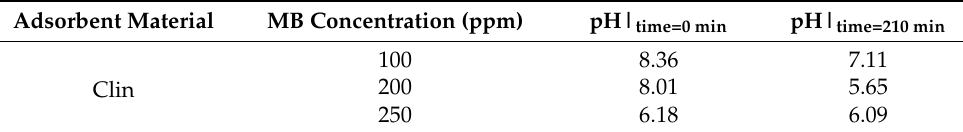
Table 3. pH values at the beginning (t = 0 min) and the end (t = 210 min) of MB abatement tests.